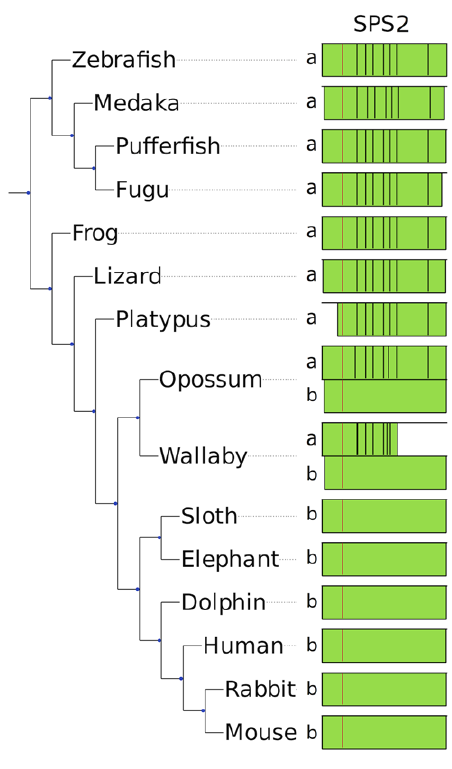
Figure 2. Replacement of a multiexon SPS2a by an intronless SPS2b. In the figure, the SPS2 genes found in some representative species are shown. The positions of introns along the protein sequence are displayed with black lines, and the Sec residue is displayed in red. In a few cases, the predicted genes were incomplete because of poor sequence data (e.g., the N-terminal region in platypus). Placental mammals (bottom) possess a single intronless gene, SPS2b. Non- mammalian vertebrates (top) and platypus possess a single multiexon gene, SPS2a. Marsupials (opossum and wallaby) possess both.